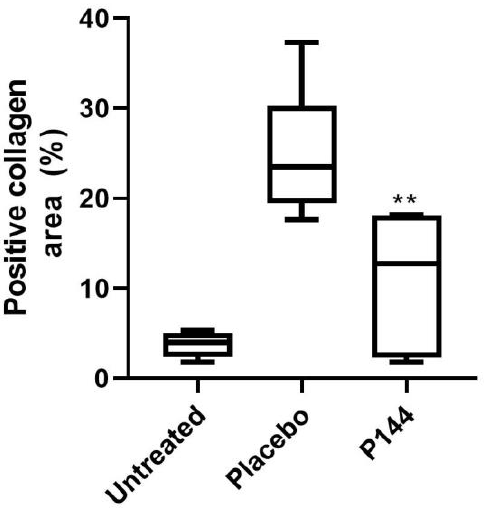
Figure 4. Masson ´ s Trichrome staining example 10 × : ( A ) Normal Tissue, ( B ) P144 group, ( C ) Placebo group.